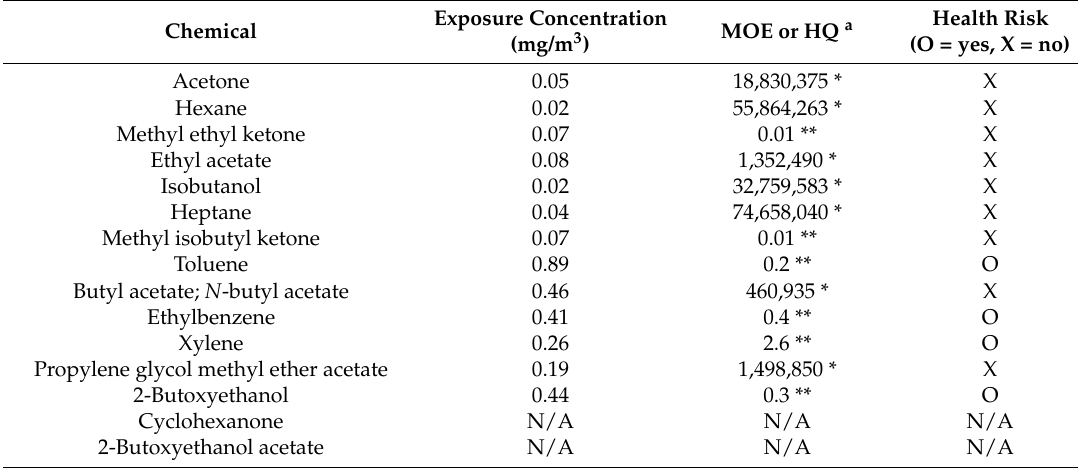
Table 6. Tier 1 assessment results.